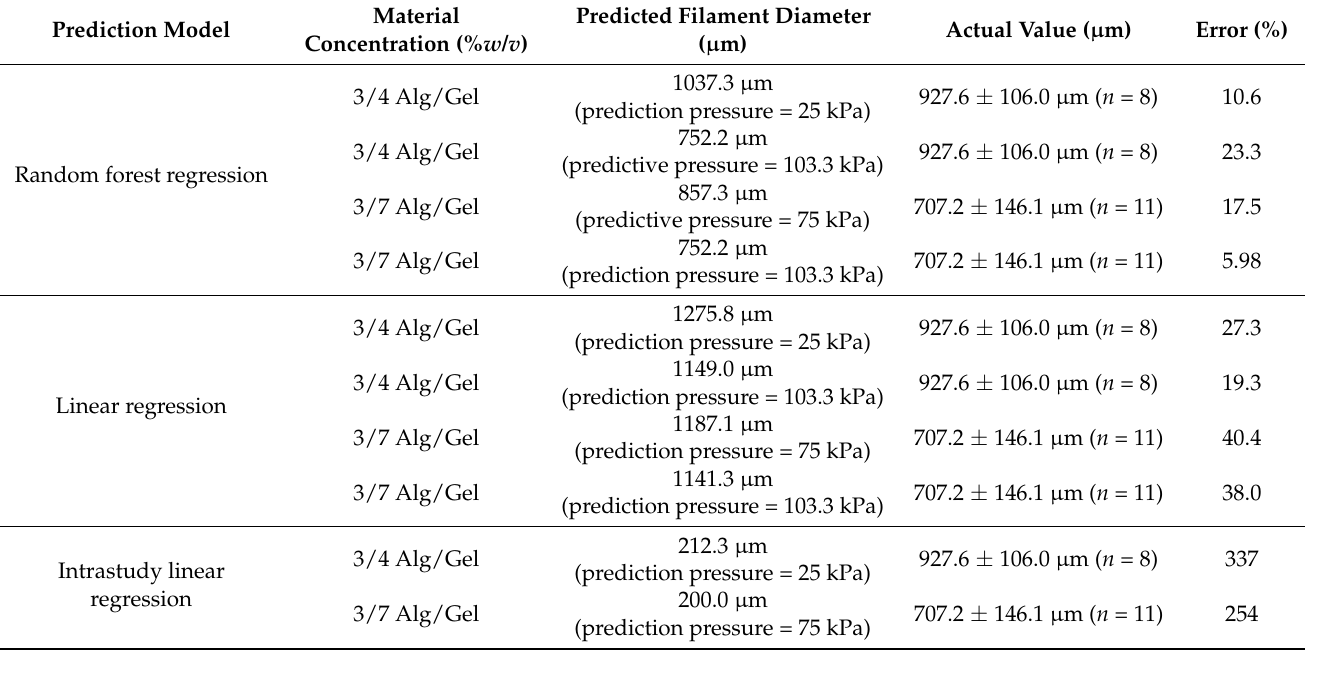
Table 2. Predicted filament diameter values are compared against experimental values for corresponding material concen- trations of alginate and gelatin. Actual values represent the mean ± standard deviation for all samples ( n = number of samples) measured from at least three batches of Alg/Gel bioink.